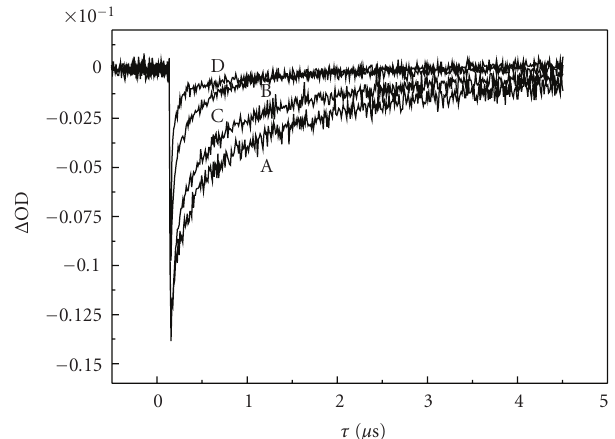
Figure 13: Decay kinetic of photooxidized Z907 adsorbed on TiO 2 in the presence of various electron mediators: (A) no ; (C) 0.1 M PTZ; (D) 0.1M Fc. mediator; (B) 0.1 M Co(DTB) 2+ 3 Di ff erential absorbance changes are measured at 480nm. Pulse energy: 5mJ/cm 2